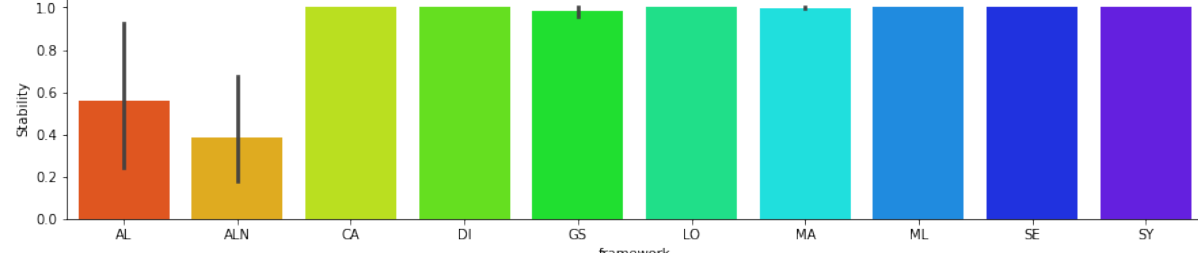
Figure 5. Mean stability of each algorithm for all datasets. The gray lines show the minimum and maximum value reached analyzing it for each dataset type (numerical, categorical, mixed). The algorithms CA, DI, LO, ML, SE, and SY have maximum stability for all datasets. While AL has minimum stability for mixed datasets and maximum stability for numerical, ALN has minimum stability for numerical datasets and maximum stability for categorical datasets, GS has minimum stability for mixed datasets and maximum stability for numerical and categorical datasets, and MA has minimum stability for numerical datasets and maximum stability for categorical and mixed